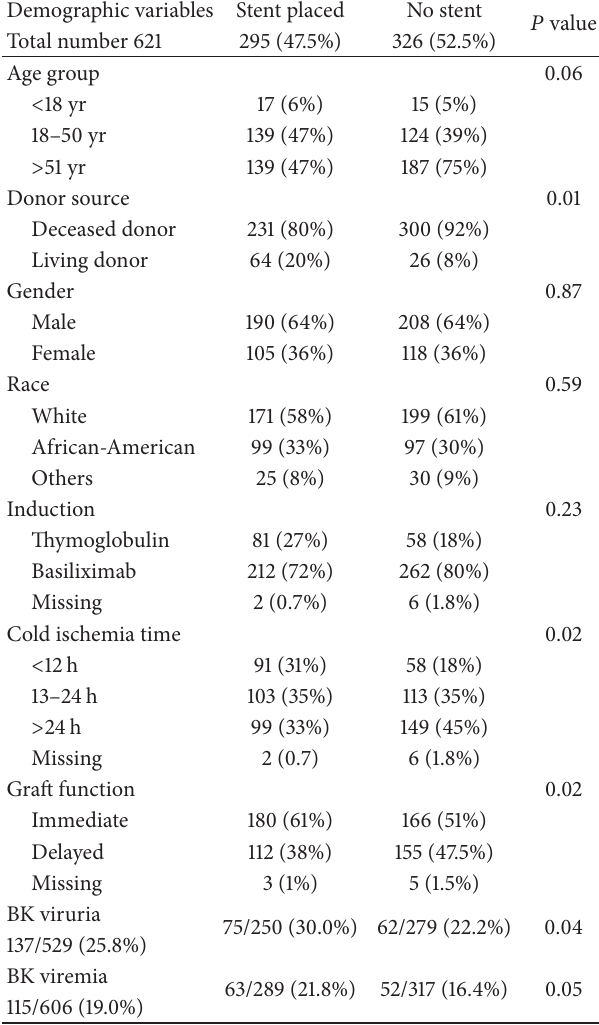
Table 1: Study group demographics based on stent placement. Demographic variables Stent